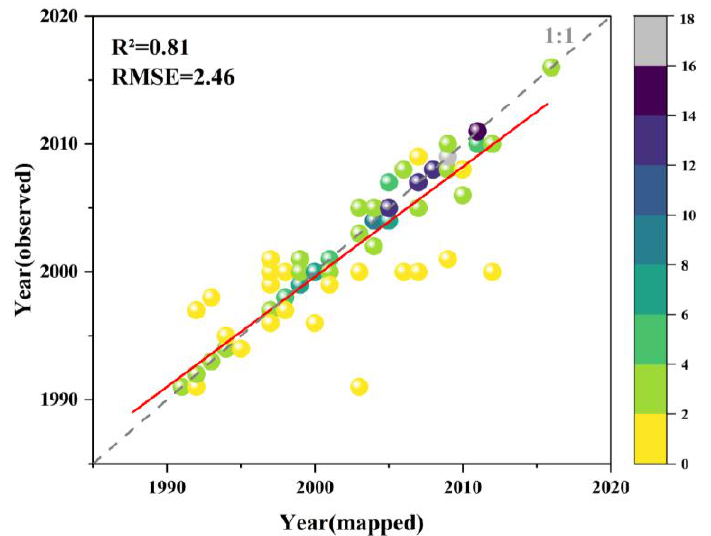
Figure 11. Comparison between the mapped and observed years of forest planting. The colorful dots simultaneously represent the two data sources for the planted forest sample, and the color represents the number of dots in the same position; the straight red line is the linear regression between the two data sources.